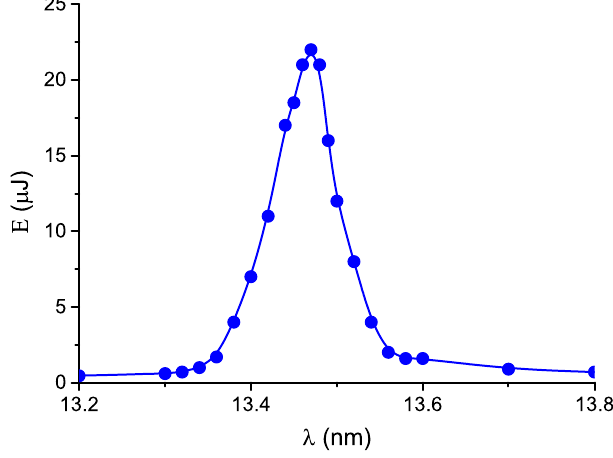
FIG. 8. Scan of the resonance wavelength of the first part of the undulator consisting of three undulator sections. Pulse energy is measured after the second part of the undulator tuned to 4.5 nm and operated close to the FEL